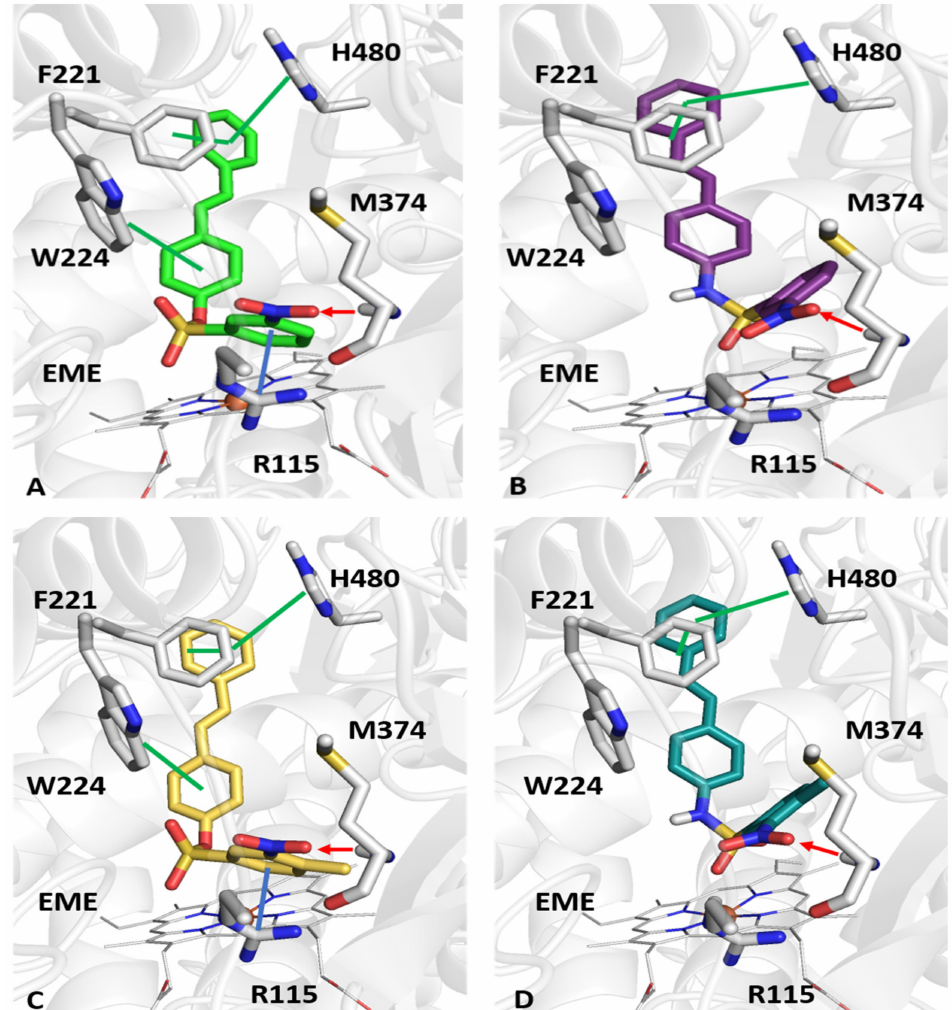
Figure 10. Zoomed in view at the aromatase CYP19A1 binding pocket. Panels ( A – D ) show the posing for compounds 1b , 2b , 1c , and 2c , which are depicted as green, purple, yellow, and deep teal sticks, respectively. π – π contacts and dipole interactions are reported as green and blue lines while hydrogen bonds are represented as red